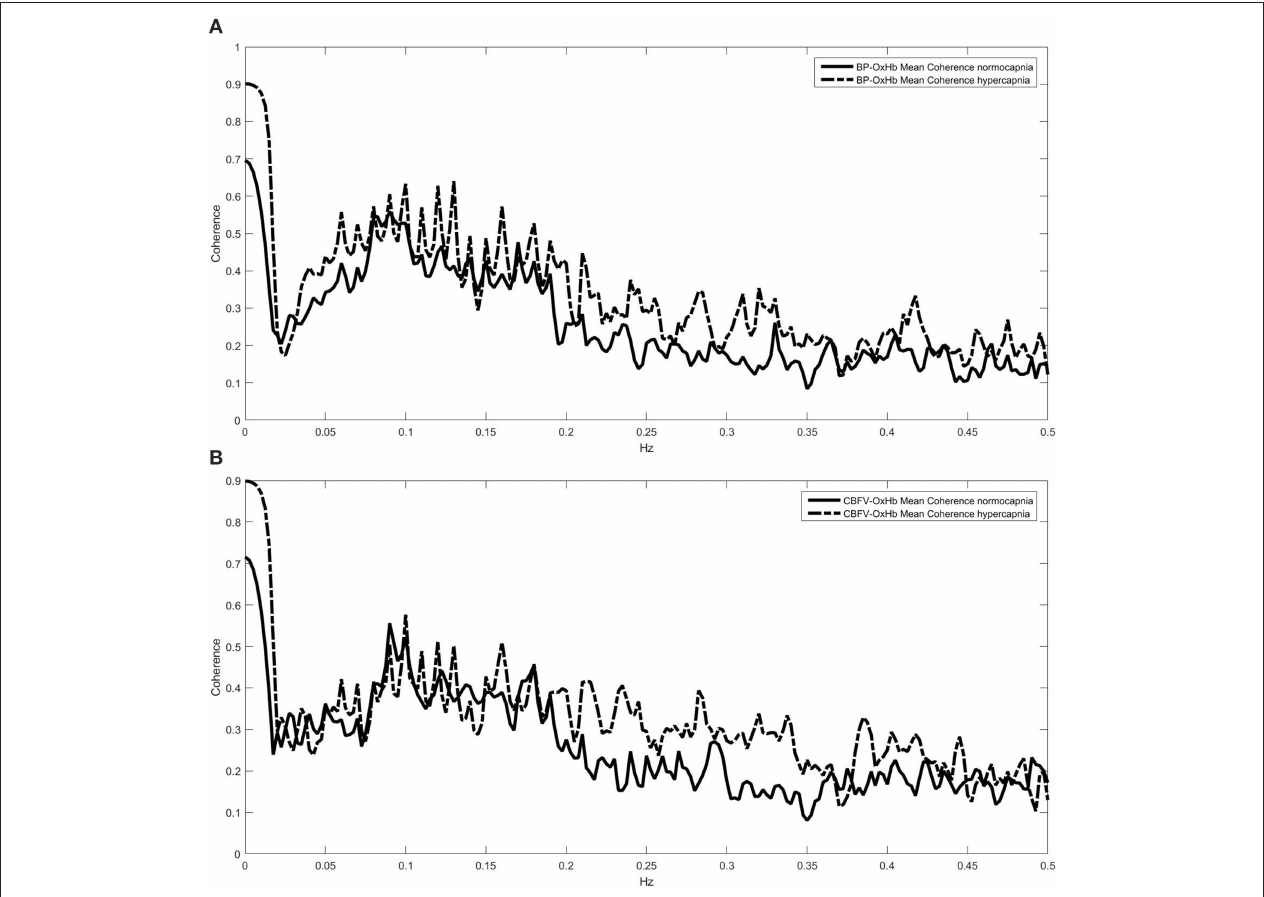
FIGURE 2 | Coherence spectra under normo- and hypercapnia for the blood pressure (BP)—oxygenated hemoglobin (OxHb, A), and the cerebral blood flow velocity (CBFV)—OxHb systems (B). In both systems coherence indicates that further transfer function estimations are reliably performed in the 0.05–0.20Hz range